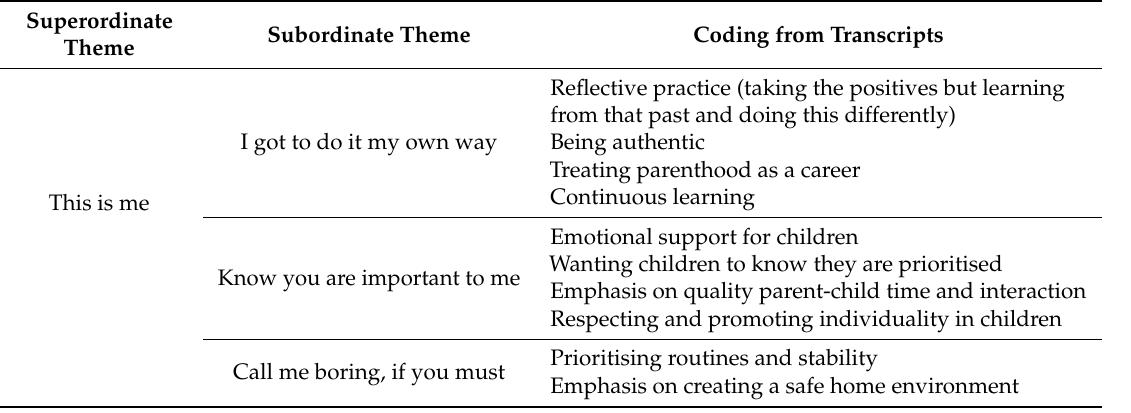
Table 2. Superordinate and subordinate themes for: ‘this is